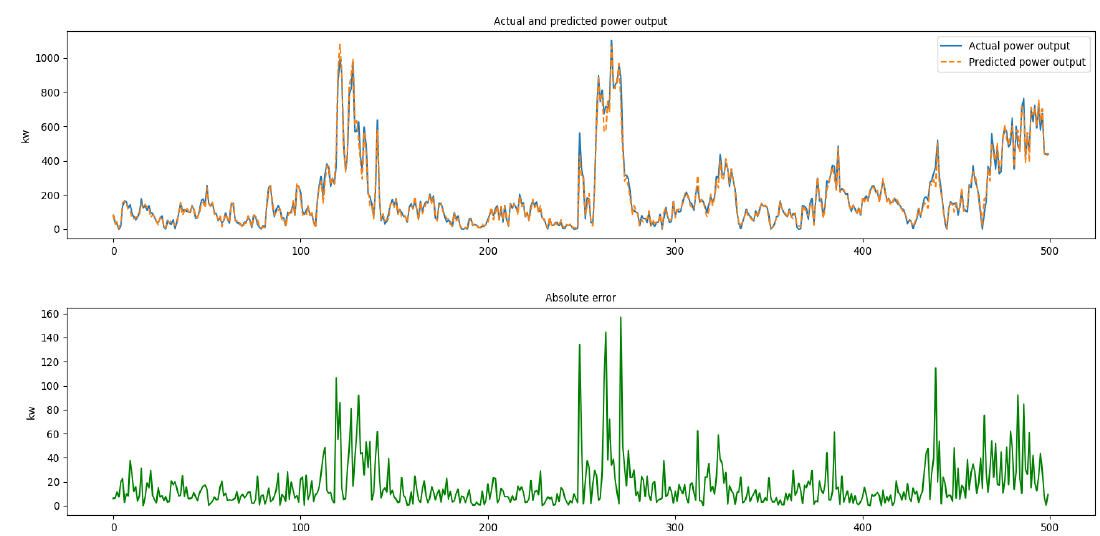
Figure 8. Power prediction on test data (#70, top 500 test points).